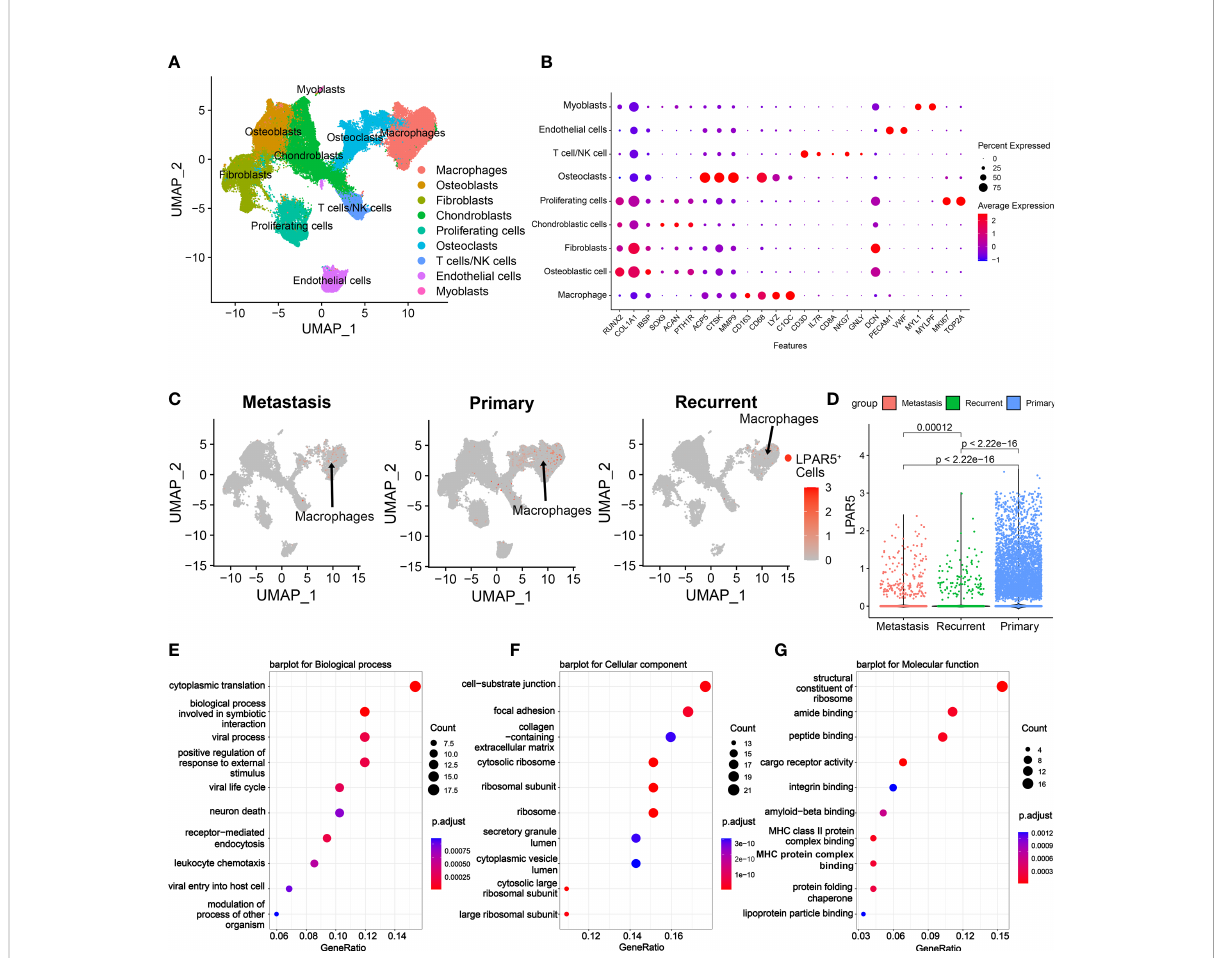
FIGURE 10 Single cell RNAseq analysis. (A) UMAP plot showing the cell clusters in the TME. (B) Expression of marker genes of cells in the TME. (C) UMAP plot showing cell clusters, which expressed LPAR5, in the metastasis patients, the primary patients and the recurrent patients, respectively. The gray dots indicate LPAR5-negative cells. The red dots represent the LPAR5-positive cells, and the darker the color, the higher the expression of LPAR5. (D) Violin plot showed that LPAR5 expression was higher in primary patients than metastasis patients and recurrence patients. (E) A barplot for biological process. (F) A barplot for cellular component. (G) A barplot for molecular function.